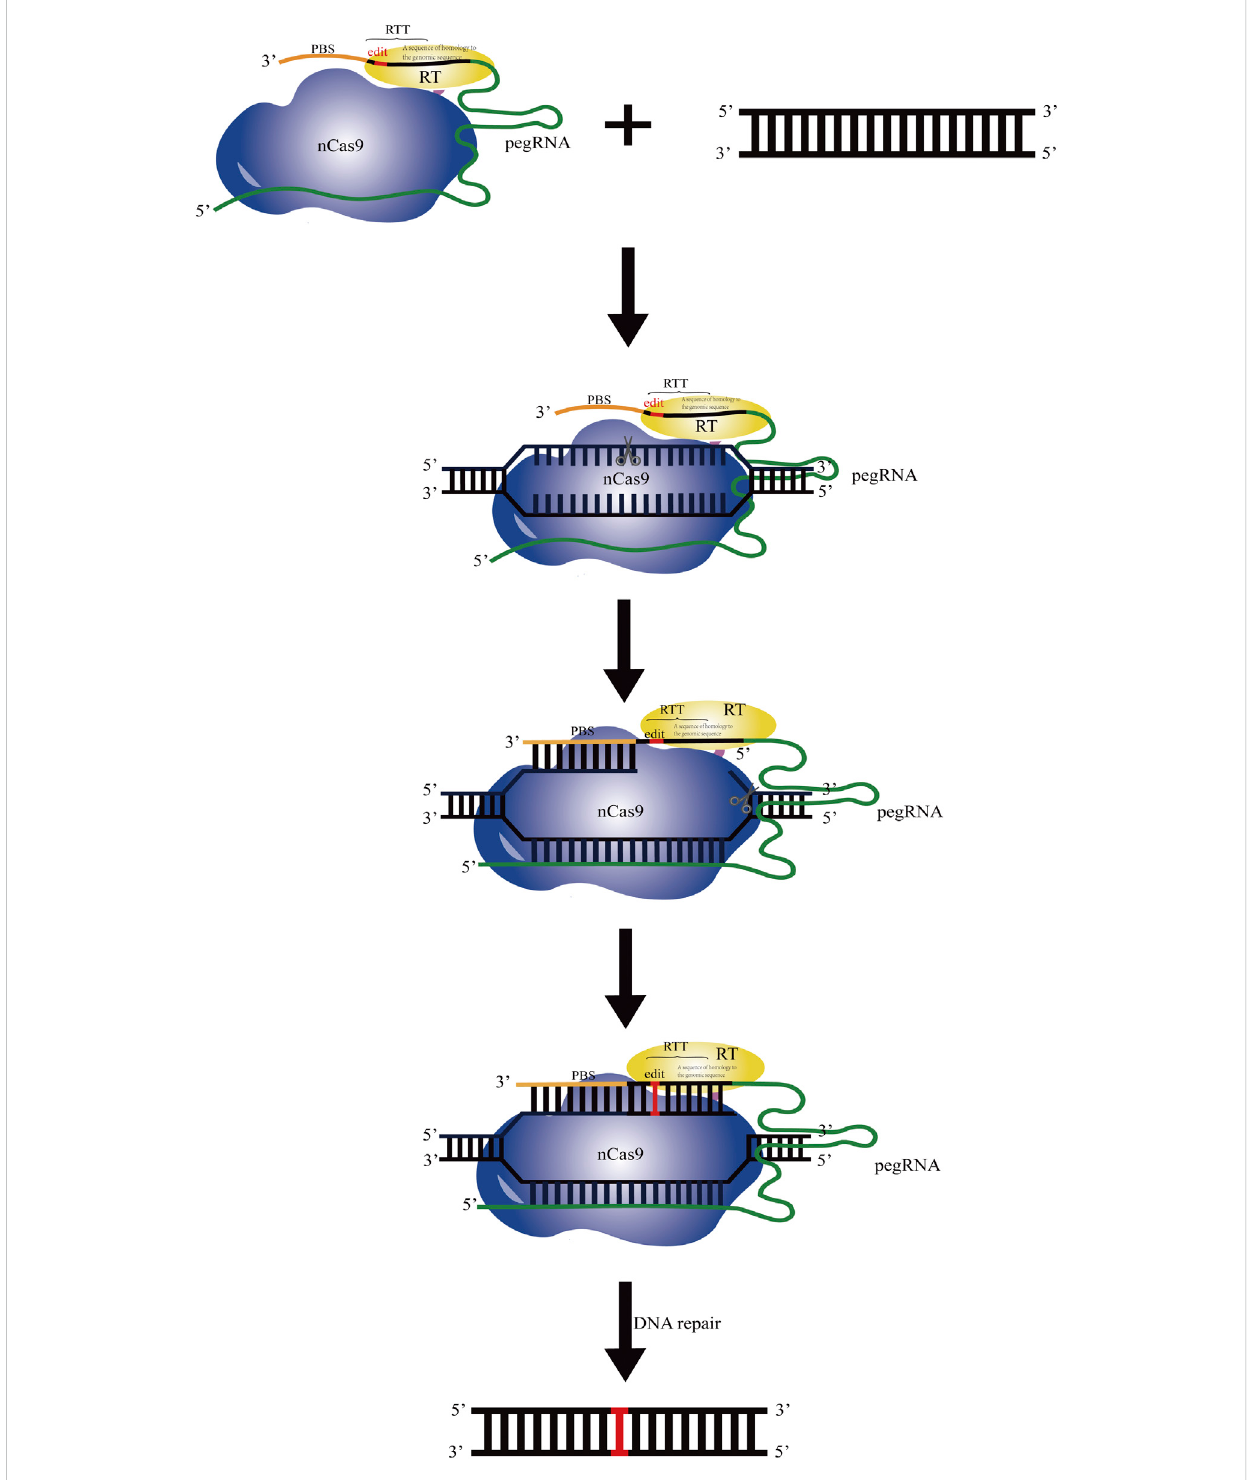
FIGURE 1 Schematic diagram of the operating principle based on the prime editing system. The PE system consists of the effecters formed by integrating nCas9 (H840A) (indicated in blue) and the moloney murine leukaemia virus reverse transcriptase (M-MLV-RT) (indicated in yellow) and the prime editing guideRNA(pegRNA).UnderguidanceofthesgRNAsequenceinpegRNA,nCas9cutstheDNAsinglestrand.Theprimerbindingsequence(PBS,indicated in brown) at the 3 ′ end of pegRNA recognizes and pairs with the complementary sequence before the cutting site. Using the arti fi cially designed